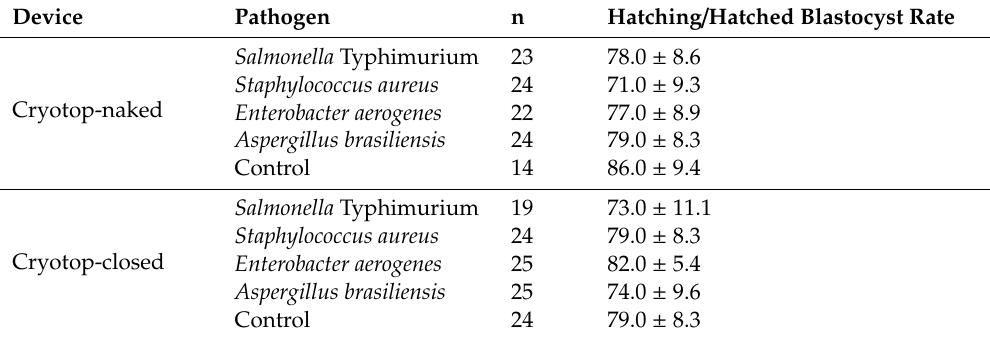
Table 2. In vitro embryo development acquired after experimental infection of rabbit embryos at the morula stage after 1 year of storage in a microorganism-free liquid nitrogen biobank, using two cryostorage